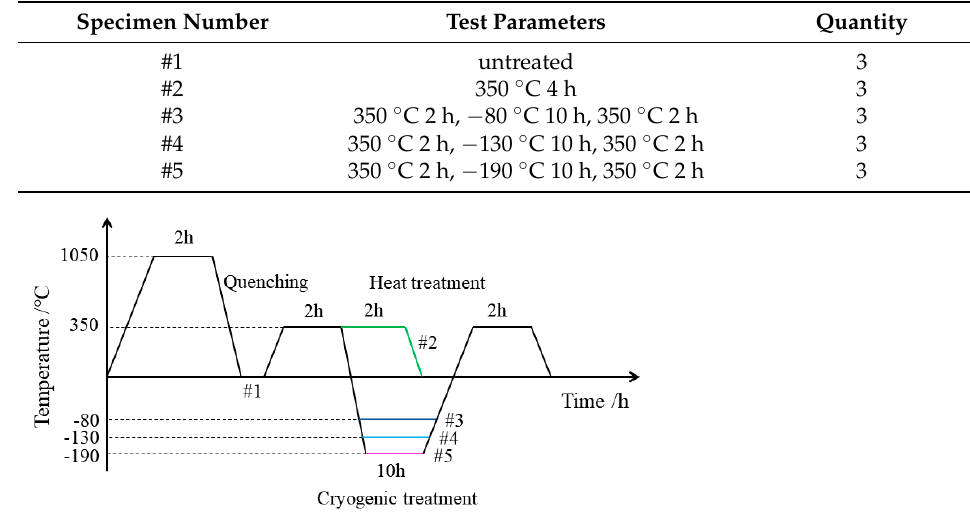
Figure 1. Schematic diagram of cryogenic treatment process.